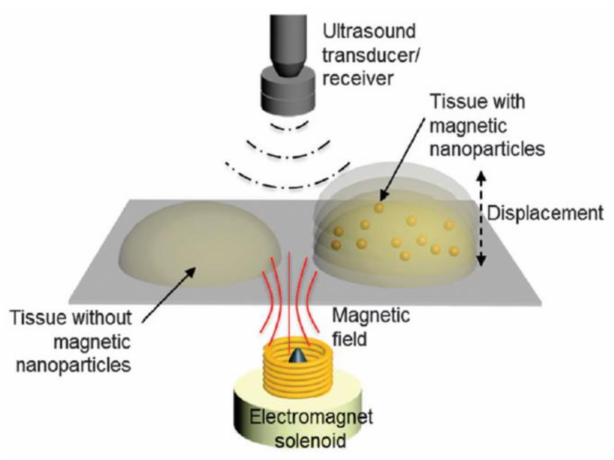
Figure 18. Schematic overview of a magneto-motive ultrasound imaging (MMUI) system. Mag- netically induced displacement of the tissue embedded with magnetic nanoparticles generates an MMUI signal, which is detected using an ultrasound receiver. Adapted with permission from [18], Copyright 2015 The Royal Society of